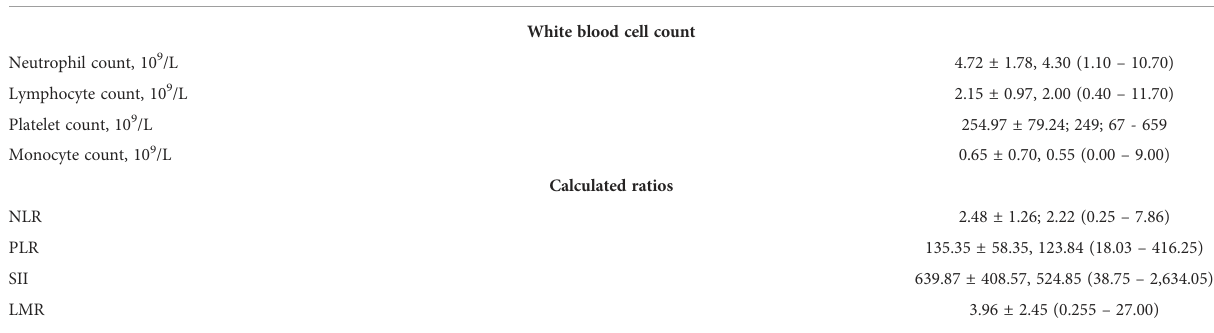
TABLE 2 Evaluation of in fl ammatory markers and ratios in peripheral blood from 348 OSCC patients.